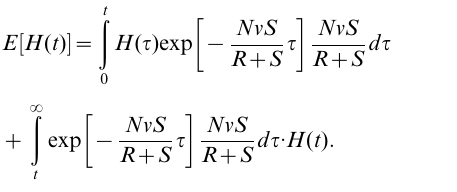
Figure 3. Tumor heterogeneity due to neutral and positively selected variation. A cell population of fixed size, N , accumulates neutral mutations at rate u per cell division. All neutral mutants have growth rate R and death rate D . Additionally, a positively selected mutant arises at time t 1 in the population. Its lineage has growth rate R z S and death rate D . The figure shows the fit of the exact stochastic computer simulation of this process with equation (11). In the simulation, heterogeneity is defined as Simpson’s index, equation (1). Parameters are N ~ 1000 , R ~ D ~ 1 , I ~ 10 4 , u ~ 10 { 2 , and S ~ 1 in (a), S ~ 3 in (b), and S ~ 100 in (c), and results are averaged over 100 simulation runs.